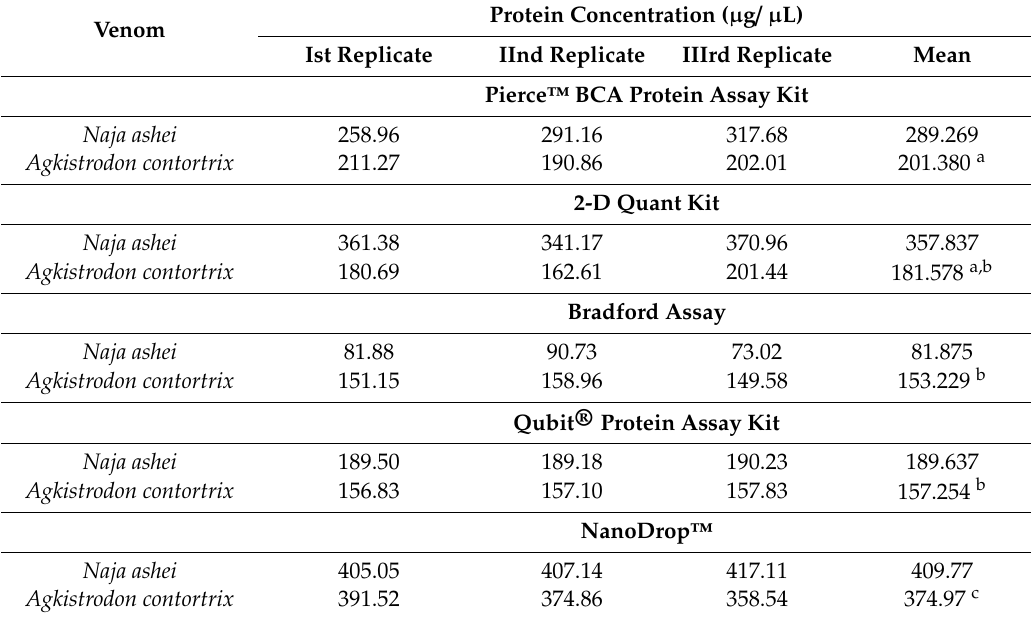
Table 1. Protein concentrations in undiluted venoms of Naja ashei and Agkistrodon contortrix measured using five different assays.